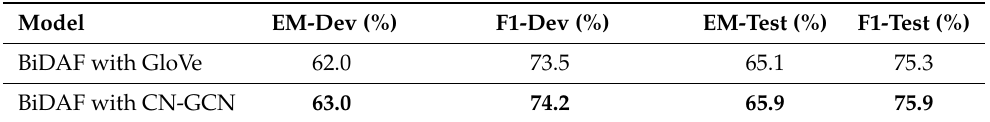
Table 4. Performance evaluation on SQuAD 1.1 with BiDAF. The performance is compared for initialization using GloVe or CN-GCN embedding. Bold indicates high performance.